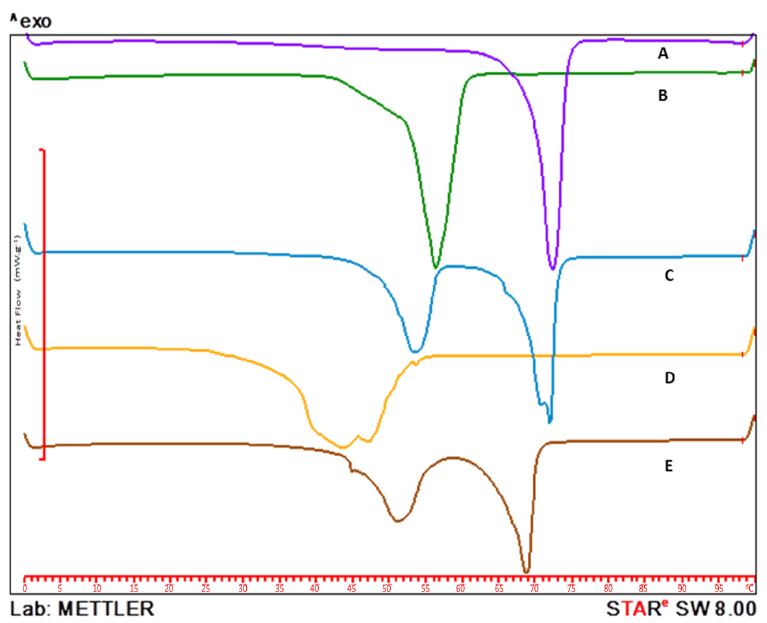
Figure 4. Overlaid DSC thermograms of (A) Compritol 888 ATO, (B) Poloxamer 188, (C) blank SLNs, (D) nicotine−stearic acid conjugate, and (E) lyophilized nicotine−stearic acid conjugate-loaded